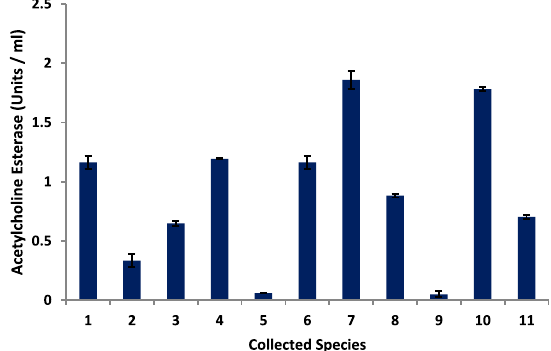
Fig. 6 Catalase activity